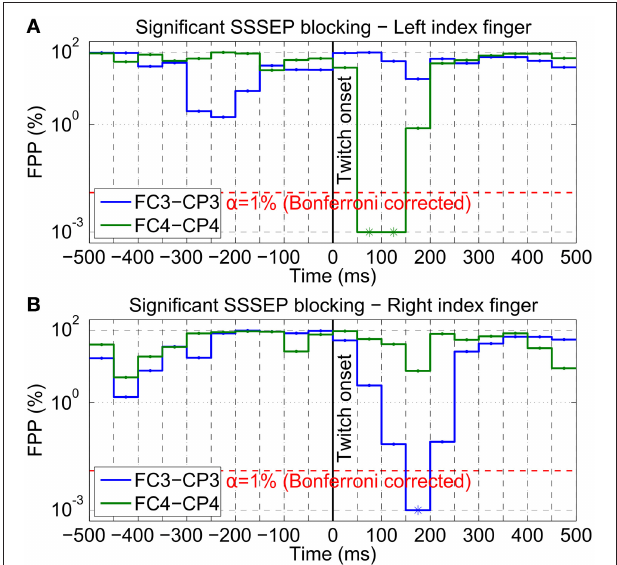
FIGURE 11 | Blocking interval estimation of subject s01. SSSEP blocking effects of (A) left-hand and (B) right-hand twitches were statistically validated using a permutation test ( 100 , 000 repetitions; 4Hz LAS bandwidth; no MAV filter). The FPP (in %; log y-axis) was estimated in steps of 50ms from − 500 to +500ms around twitch onsets for two bipolar channels (blue: FC3-CP3; green: FC4-CP4). Significant blocking effects (indicated by asterisks) can be found in intervals where the FPP is below the indicated significance level ( α = 1 % ; Bonferroni corrected; red dashed line).